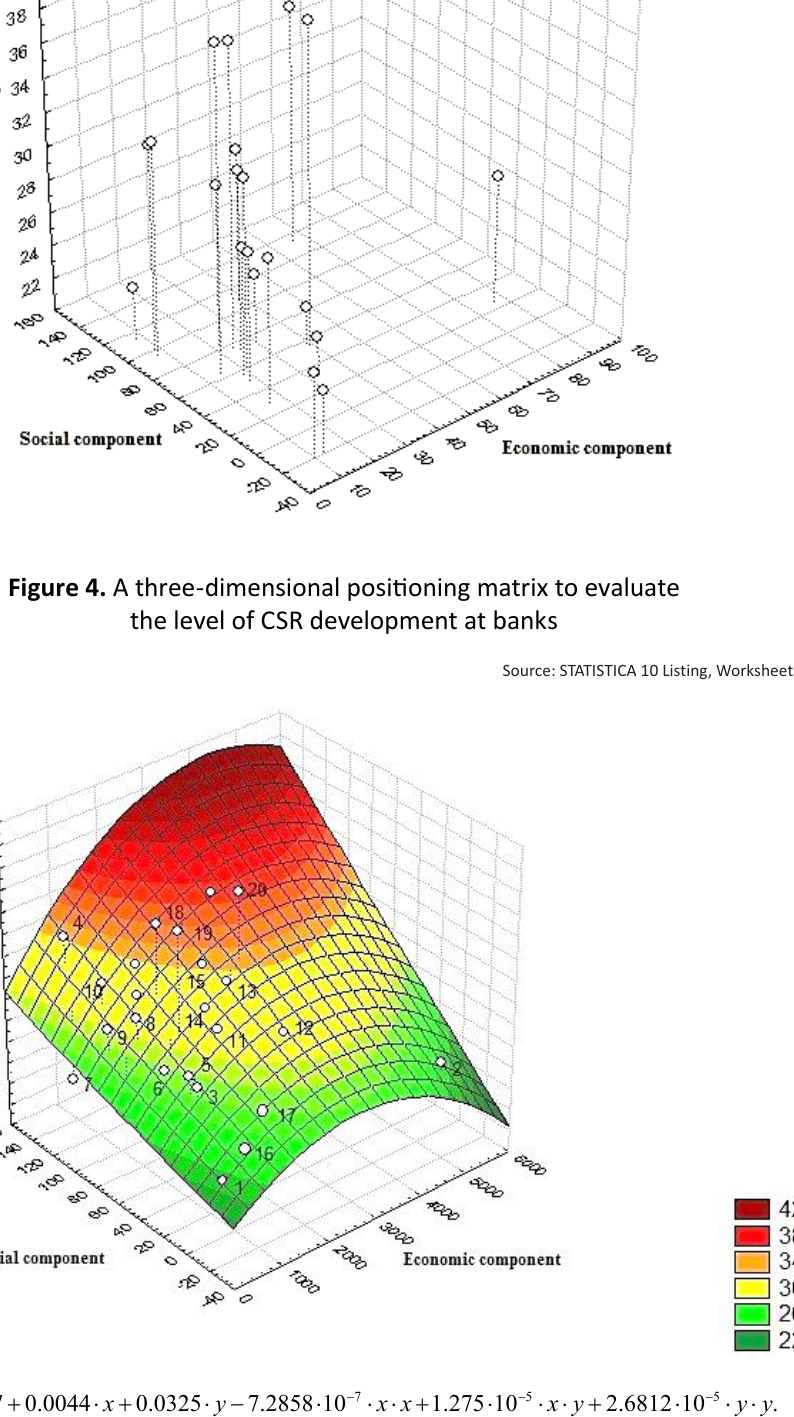
Figure 5. A three-dimensional matrix of corporate social responsibility areas for the TOP 20 banks operating in the territory of Ukraine, according to the Ranking